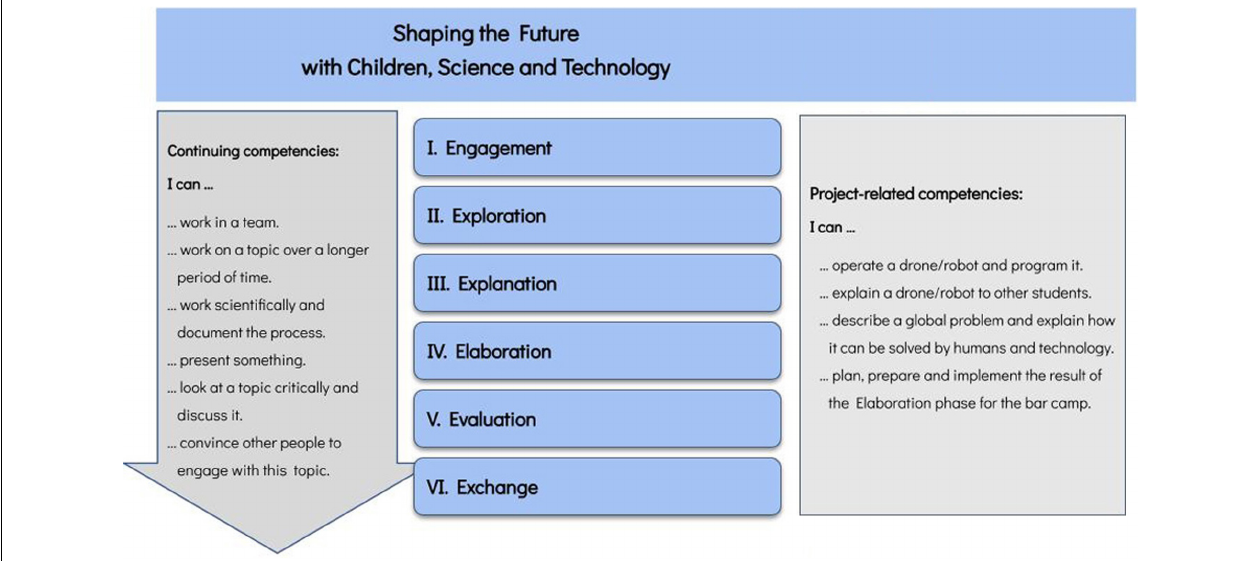
build on their skills in communication as well as problem